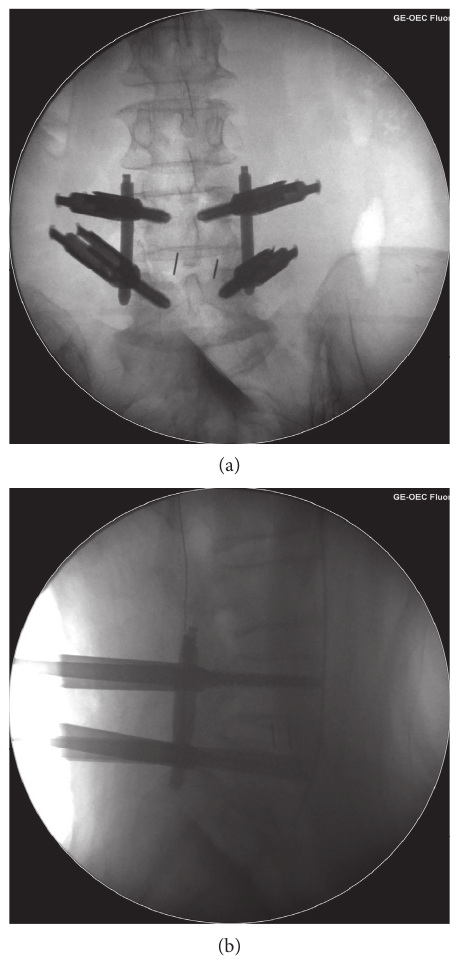
Figure 4: Intraoperative fluoroscopy images in group GE-FLU: AP X-ray image (a) and lateral X-ray image